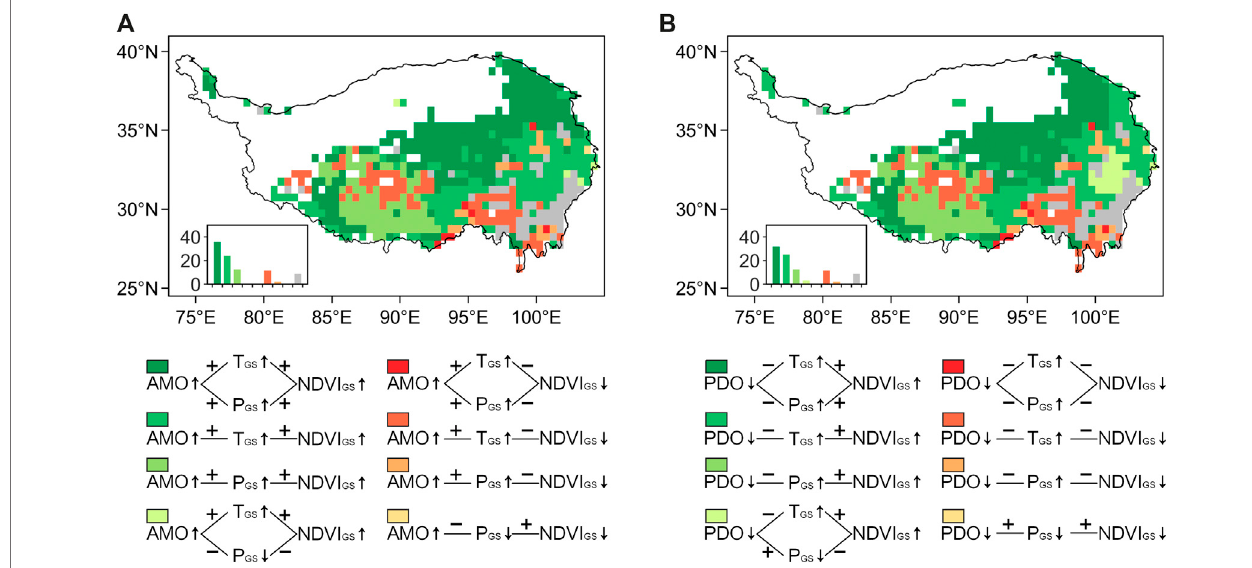
FIGURE5| DifferentmodesshowinghowthetemporalchangesoftheAMO (A) andPDO (B) indicesaffectedtheNDVI GS bymodifyingtheT GS orP GS .Bottom-left insetineachmapshowsthepercentageofpixelsineachmode.Themodesareindicatedbythecolorinthelegendatthebottomofeachmap.Theupwardordownward arrow totherightofeachvariableindicatespositiveornegativetrendsofthatvariable. Apositiveornegativesignnearthelinebetweentwovariablesindicatespositiveor negative correlations between them. If two variables connected by a line were positively (negatively) correlated, we considered only the case in which the trends of the two variables shared the same direction (opposite directions), and these pixels are colored in green and yellow on the map. Otherwise, the pixel was colored gray.